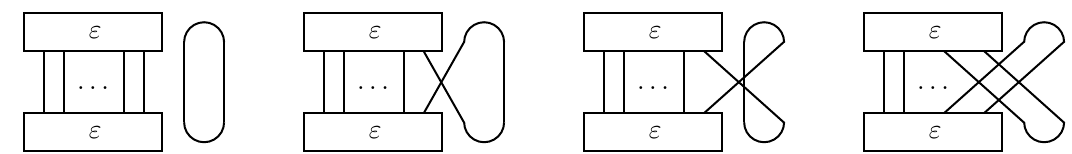
Figure 14 . Diagrammatic calculation of C ( (cid:12) ) for (cid:12) = 1 ; ( N; N + 1) ; ( N; N + 2) and ( N (cid:0) 1 ; N